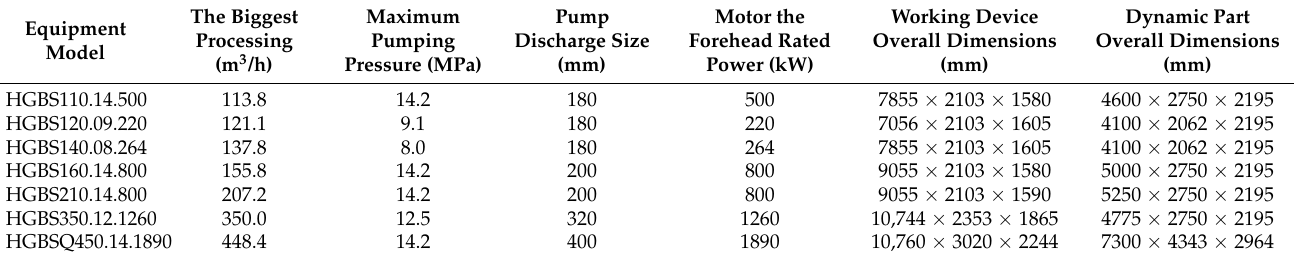
Table 2. Cain technical parameters of HGBS series filling industrial pump of Fei-yi Co., Ltd. The Biggest Equipment Processing Model